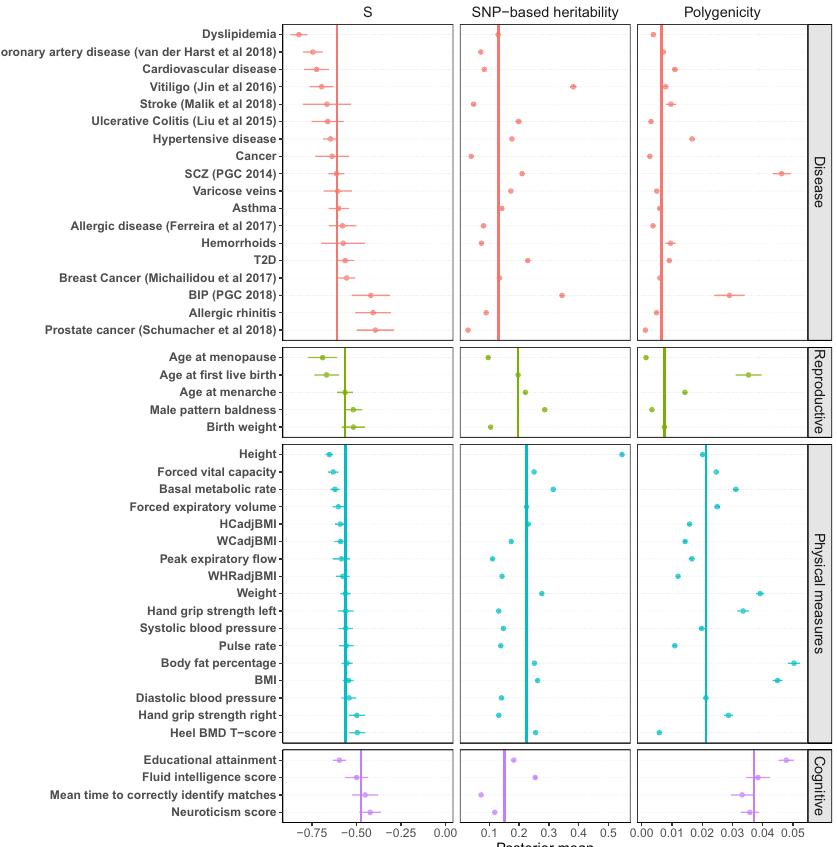
Fig. 2 Estimation of the three genetic architecture parameters for 35 traits from the UKB and 9 common diseases from published GWAS. Shown are the posterior means (dots) and standard errors (horizontal bars) of the parameters for each trait. The colour indicates the UKB trait category that the trait belongs to. The vertical bar shows the median of the estimates across traits in each